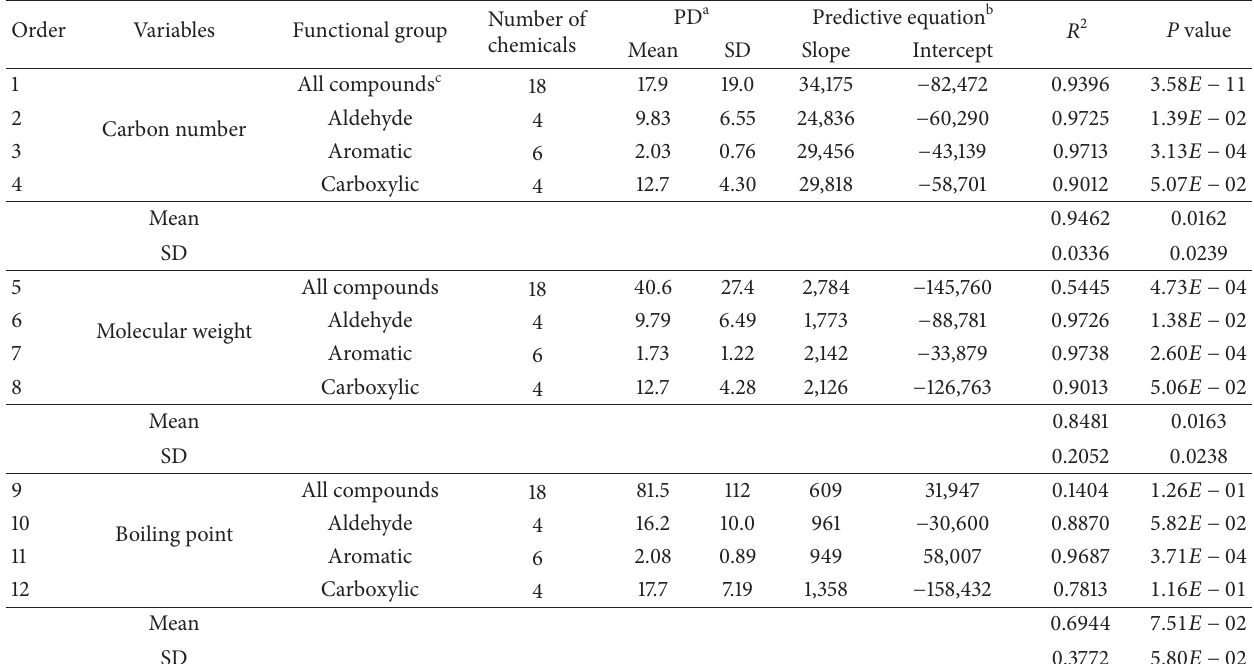
Table 5: Comparison of percent difference (PD) between the actual and projected response factor (RF) values for all ( 𝑛 = 18 ) or three chemical groups ( 𝑛 = 14 ) in relation to three major variables of reference VOCs used for prediction: (1) carbon number, (2) molecular weight, and (3) boiling